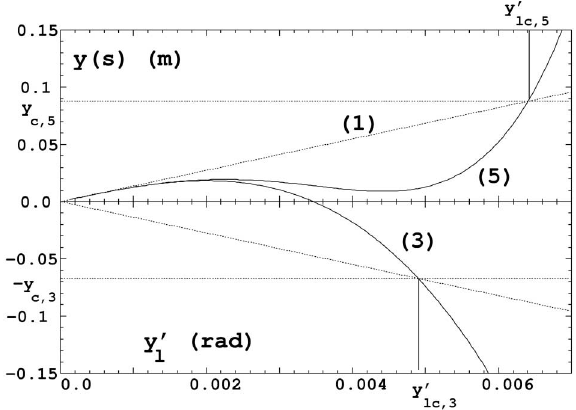
FIG. 5. Confinement critical angles y 0 lc ,2 n 1 1 ( n (cid:1) 1, 2